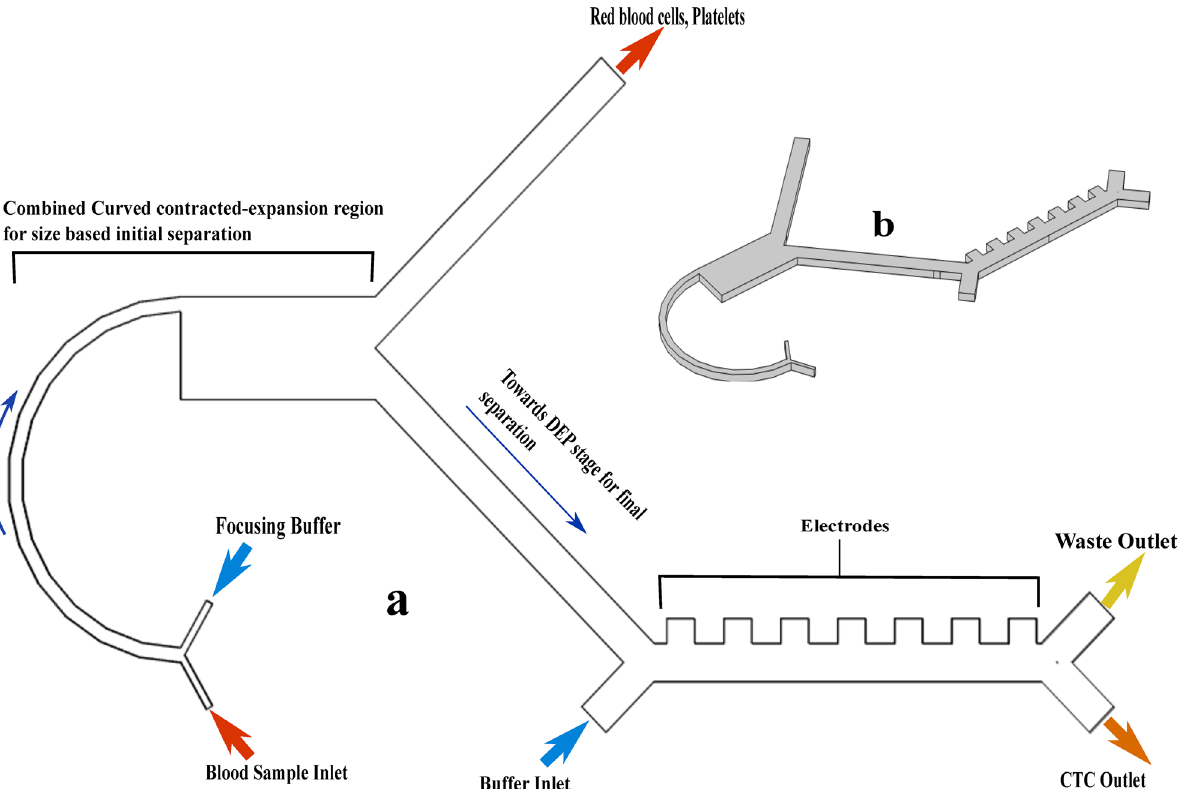
Figure 1. The 3D schematic representation of the developed device with both embedded stages. Once the blood sample is introduced through the inlet, most of the blood cells including RBCs, platelets, T-lymphocytes, and B- lymphocytes are separated in the inertial focusing stage and second stage. Finally, the rare circulating tumor cells are selectively separated using DEP and collected through outlet-II. Residual WBCs exit through waste